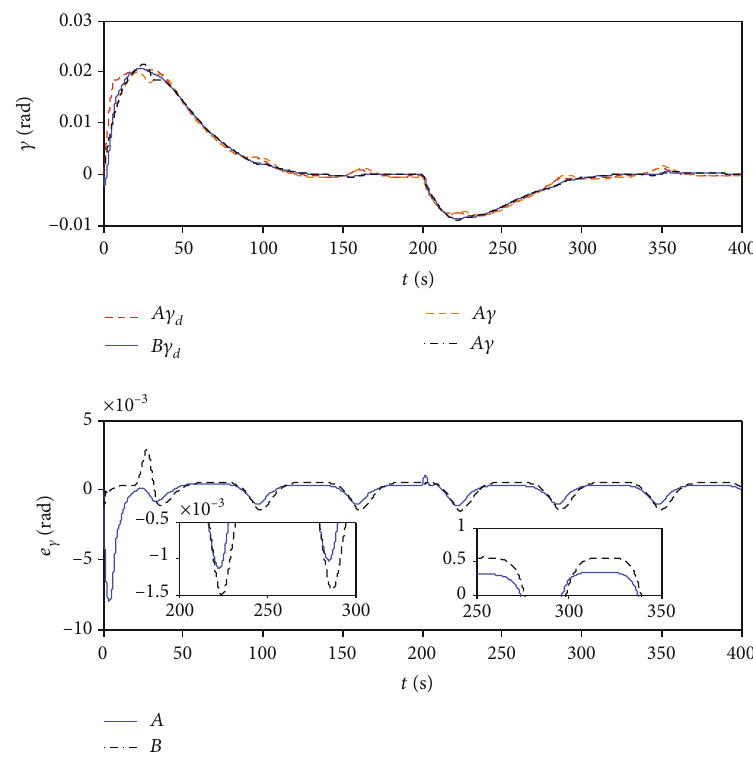
Figure 4: Curves of fi ght-path and its tracking